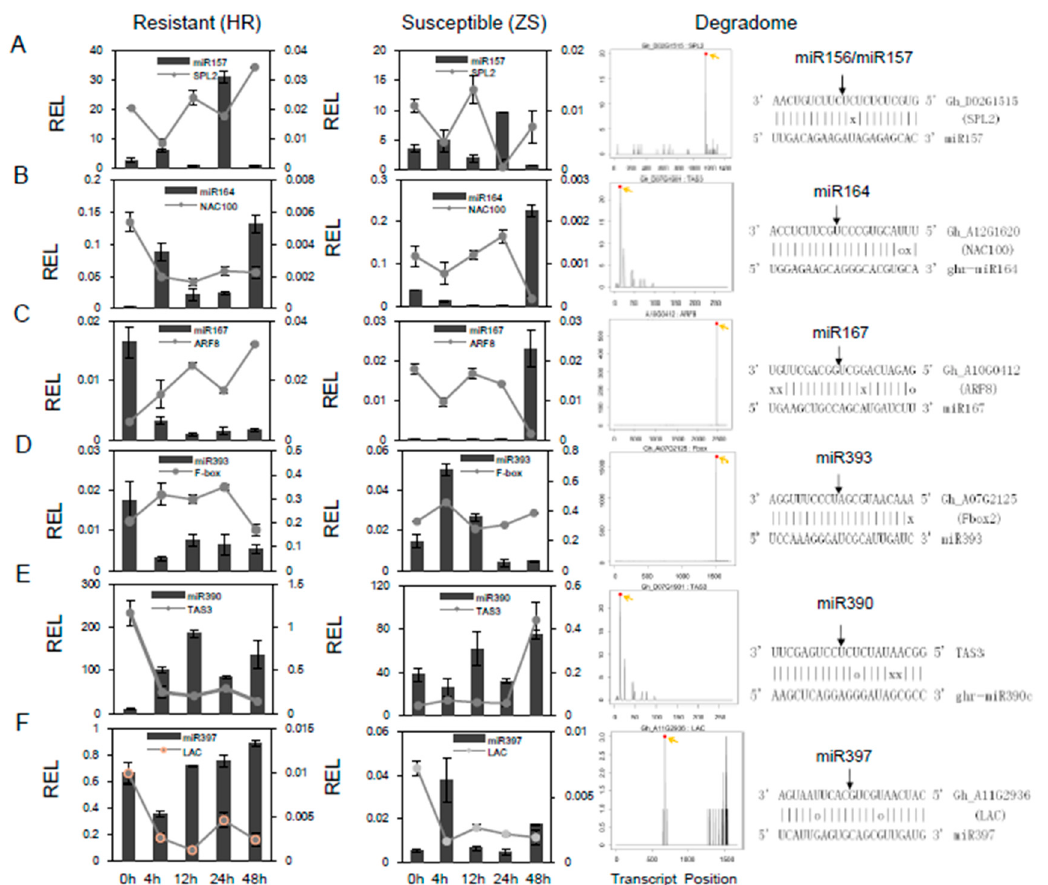
Figure 4. Expression profile of select miRNAs and their corresponding target genes in HR and ZS cotton plants following whitefly infestation. ( A – F ) The histograms and associated lines indicate the relative abundance of the individual miRNAs and their corresponding targets, respectively. The left and middle panels correspond to the expression profiles of the indicated transcripts in HR and ZS plants infested with whiteflies at di ff erent time points, respectively. The T-plots in the right panel show the relative abundance of the degradation signal mediated by the miRNAs. The associated miRNA:mRNA duplex alignment is shown above each panel. The G-U pairs are indicated with an ‘o’ and mismatch base pairs are indicated with an ‘x’.